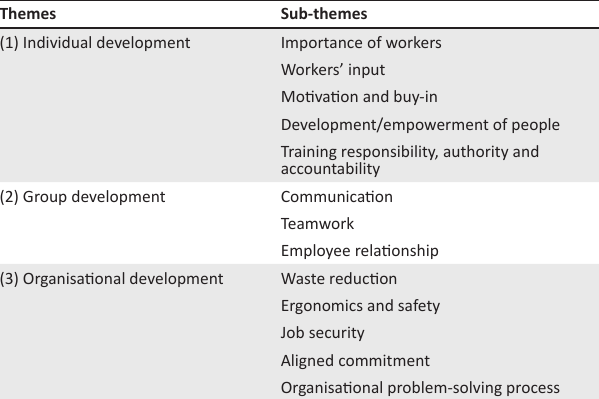
TABLE 3: Thematic map of the South African Respect for People themes and